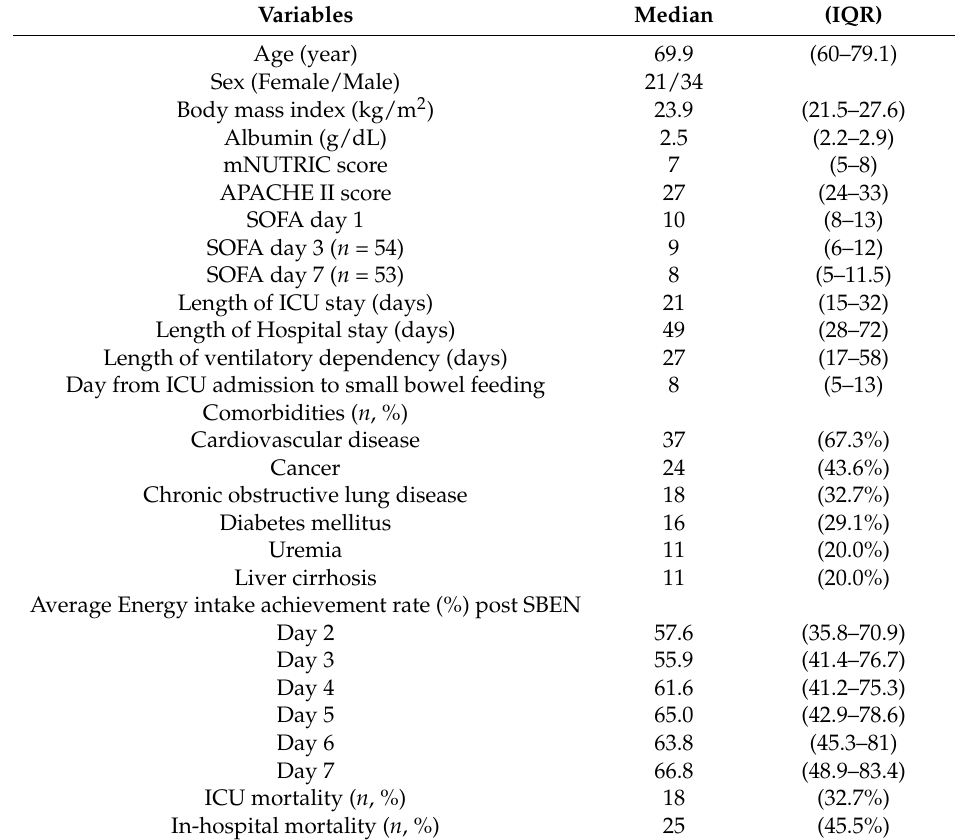
Table 1. Demographic characteristics, severity scores, comorbidities and clinical outcomes of